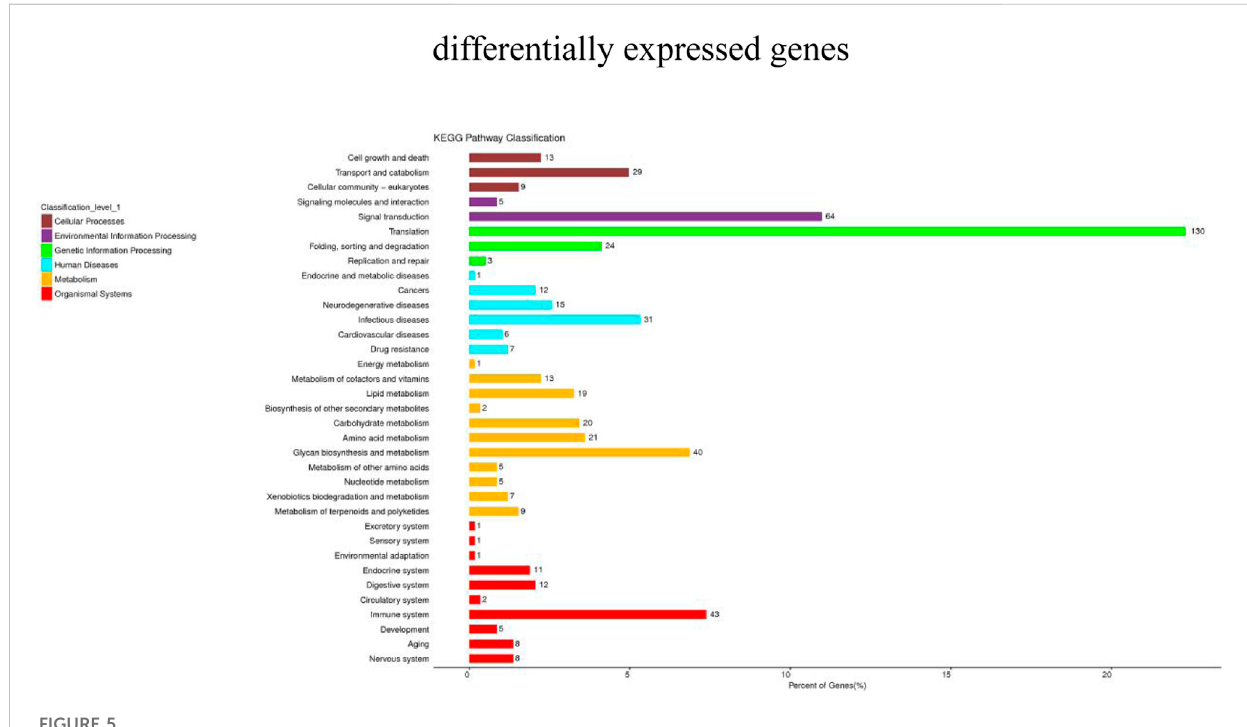
FIGURE 5 Statistical chart of KEGG Level 2 classi fi cation of